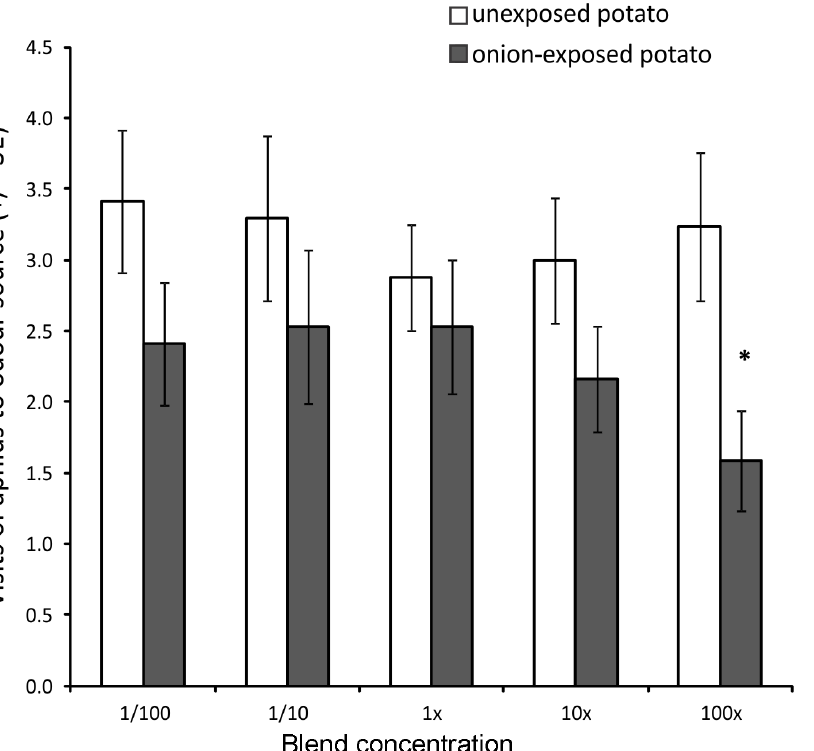
Figure 4. Aphid olfactory responses to synthetic blends of volatile organic compounds of exposed and unexposed potato. Responses of winged Myzus persicae in olfactometer experiments when presented with synthetic blends based on headspace collections of onion- exposed (treatment) and unexposed potato (control). Synthetic blends were at 1/100, 1/10, 1x, 10x or 100x the original concentration of volatiles identified in potato headspace. Error bars indicate 6 SEM. * P # 0.05 Wilcoxon test.